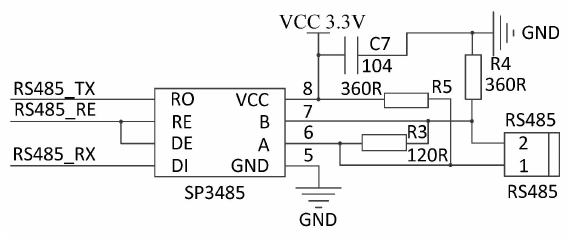
Figure 7. RS485 communication module circuit.